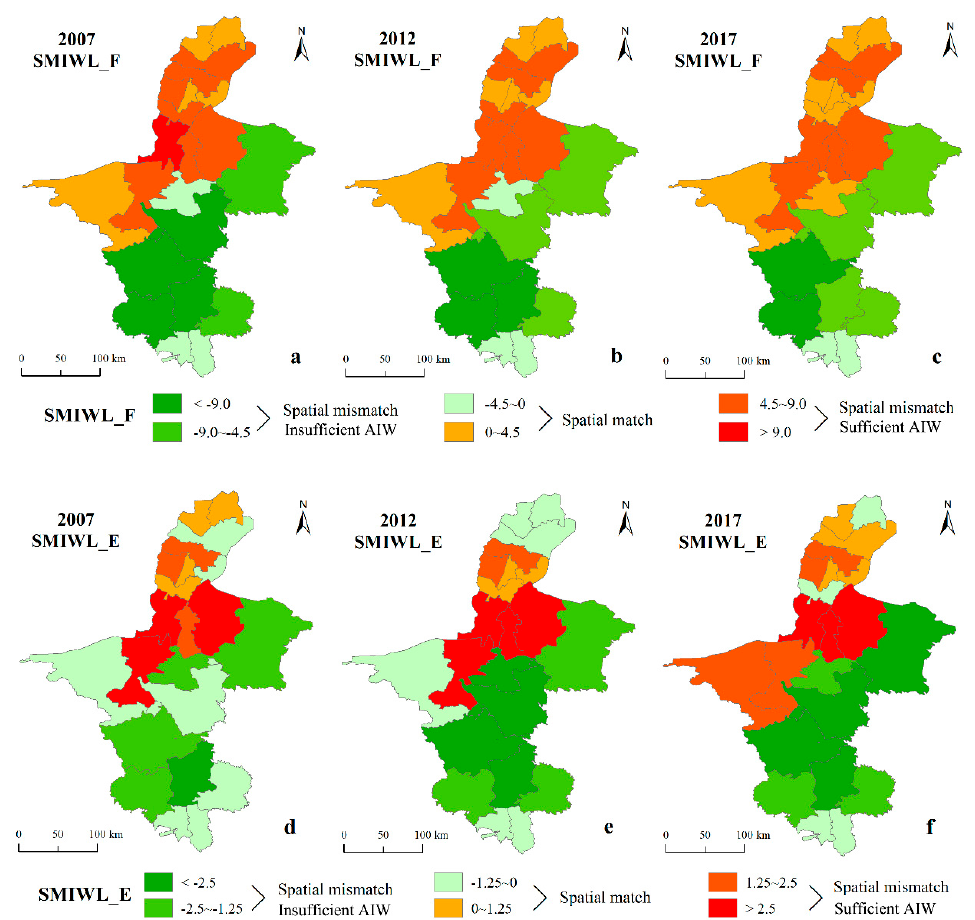
Figure 6. The spatial–temporal distribution of spatial mismatch index from 2007 to 2017. ( a – c ) represent SMIWL _ F of each county and district in 2007, 2012 and 2017, respectively; ( d – f ) represent SMIWL _ E of each county and district in 2007, 2012 and 2017,